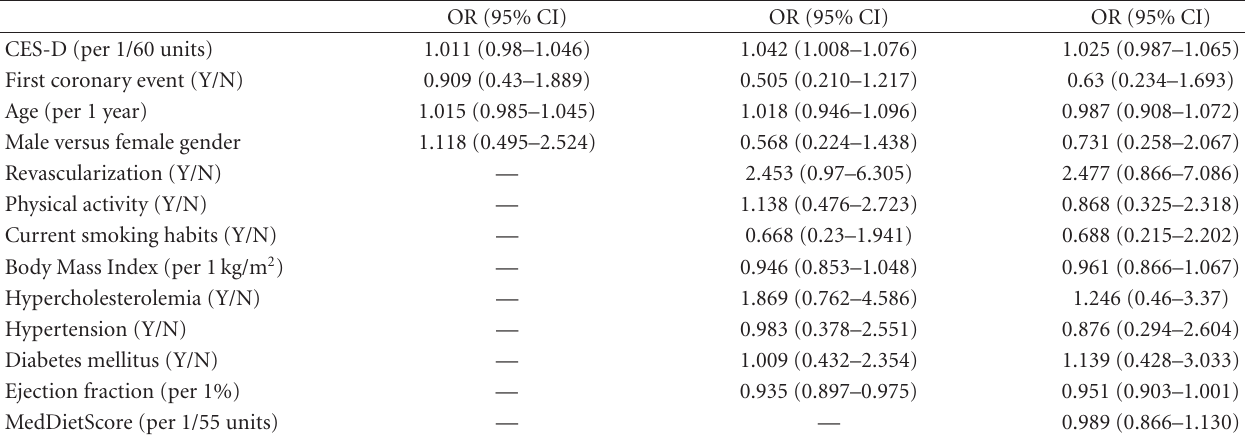
Table 3: Results from additive logistic regression models that evaluated the association of CES-D score on the likelihood of developing 30-day CVD events among n = 277 elderly ACS